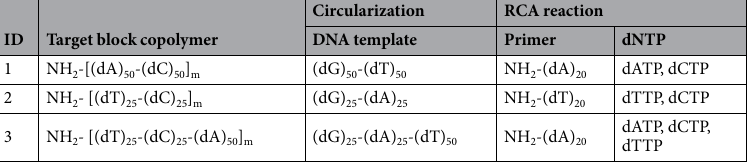
Table 2. The combination of DNA template, primer and dNTP used to prepare the block